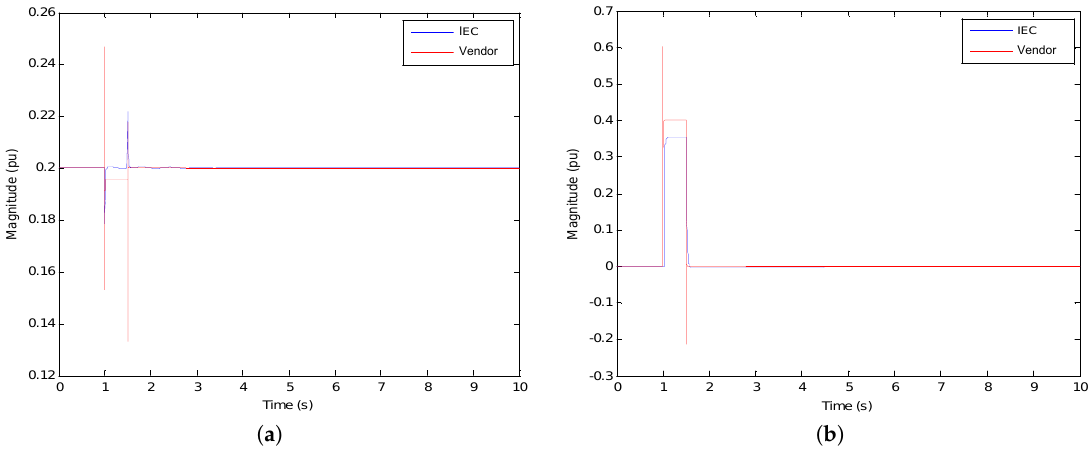
Figure 6. Type IIIB results. Simulation scenario: p = 0.20 pu, u = 0.85 pu, t = 500 ms. ( a ) Active power, p ; and ( b ) reactive current, i q